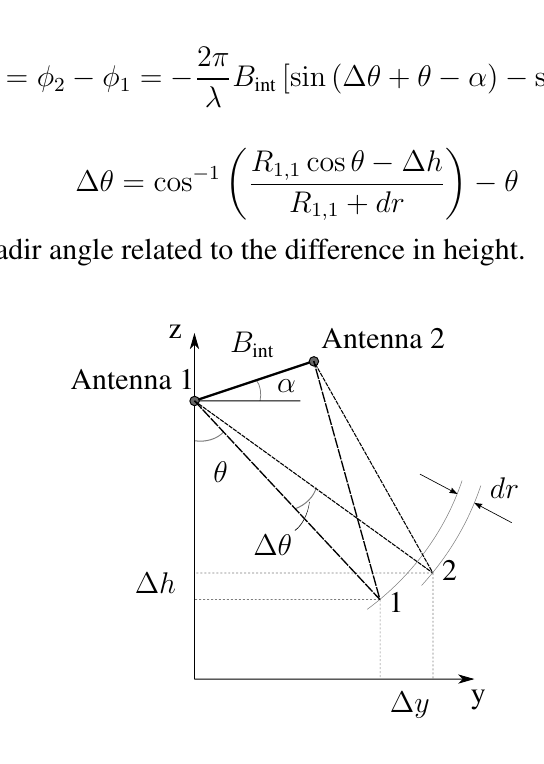
Figure 5. Interferometric observation